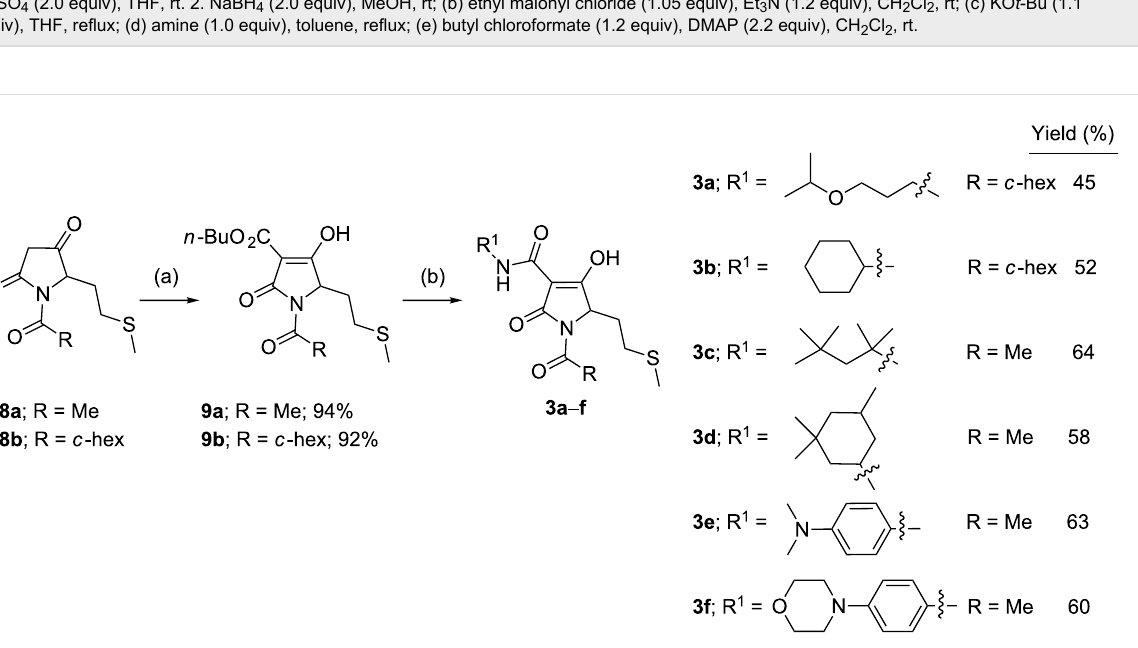
Scheme 2: Synthesis of N -alkyl 3-carboxamide tetramic acid. Reaction conditions: (a) 1. glycine methyl ester ∙ HCl (1.0 equiv), Et 3 N (1.2 equiv),